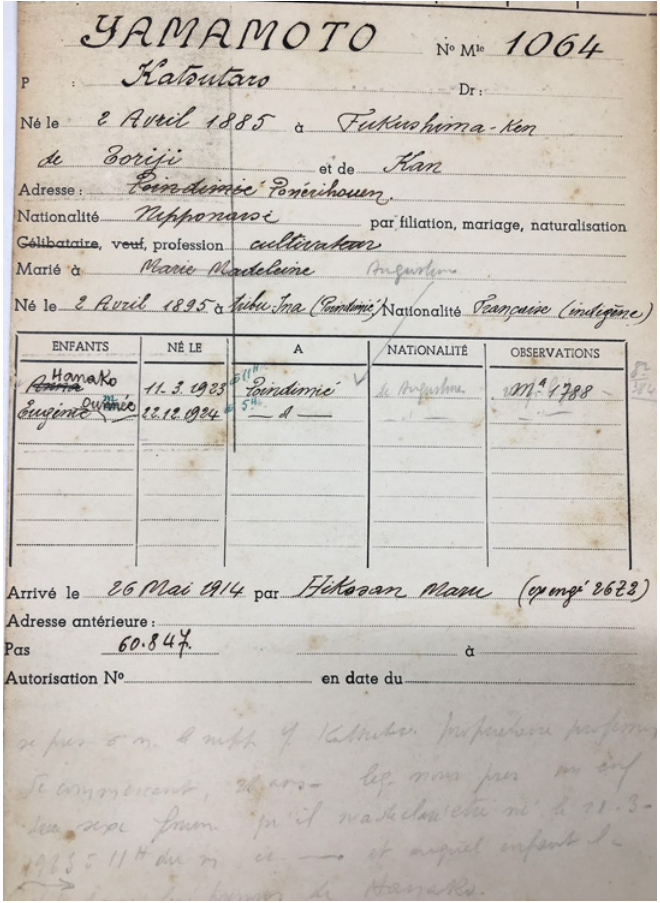
Identity card of Katsutaro Yamamoto on which his wife Marie